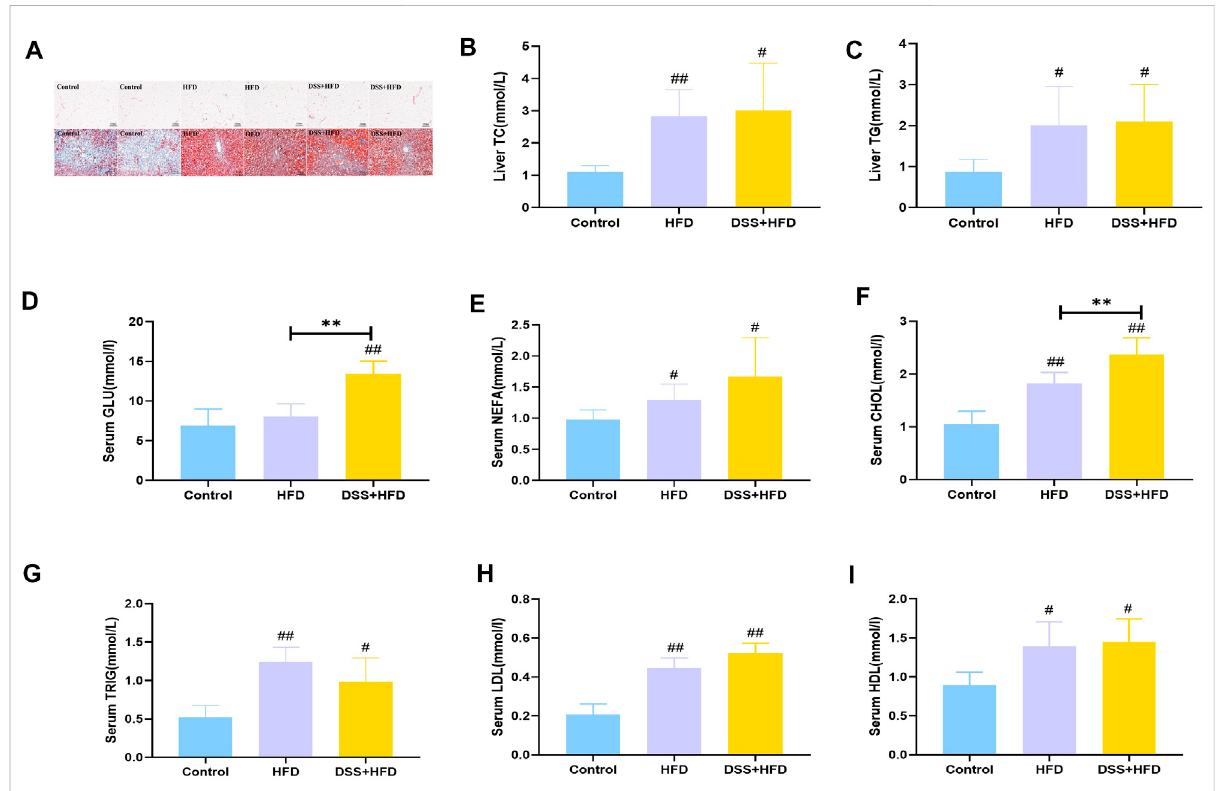
FIGURE 2 Lipid metabolism indices in each group. (A) HE staining of visceral adipose. Oil-Red O staining of liver. Pictures were taken using a microscopy with ×10 object lenses. (B) Hepatic TG contents. (C) Hepatic T-CHO contents. (D) GLU. (E) NEFA. (F) CHO. (G) TRIG. (H) LDL. (I) HDL. Values are the means ± SD ( n = 5). Control: standard chow; HFD: high fat diet; DSS + HFD: high fat diet + 1% DSS in drinking water. # p < 0.05, ## p < 0.01, vs. the control group. ** p < 0.01, vs. the HFD group.